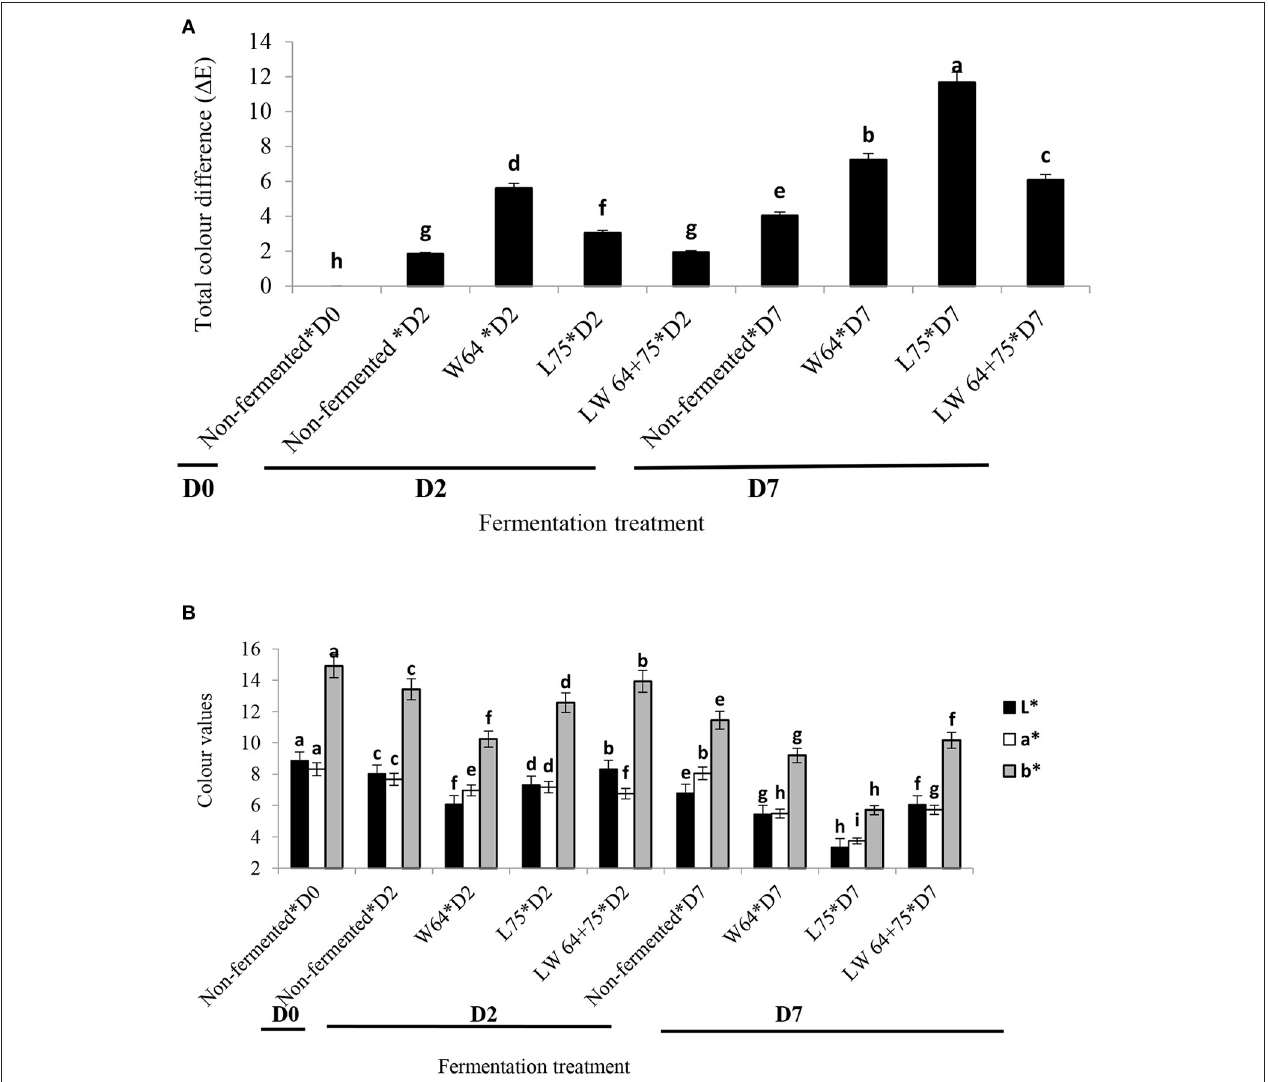
FIGURE 3 | (A) Total color difference ( 1 E ) of lactic acid fermented smoothies. Bars with different alphabetic letters are significantly different at p < 0.0001 level. W64, Weissella cibaria 64; L75, Lactobacillus plantarum 75 ; LW64 + 75, W. cibaria 64 + L. plantarum 75; D0, day 0; D2, 2 days; D7, 7 days; non-fermented smoothies (control); 1 E = change in color. (B) Color attributes ( l *, a *, b *) of lactic acid fermented smoothies. Bars with different alphabetic letters are significantly different at p < 0.0001 level. W64, Weissella cibaria 64; L75, Lactobacillus plantarum 75 ; LW 64 + 75, W. cibaria 64 + L. plantarum 75; D0, day 0; D2, 2 days; D7, 7 days; l